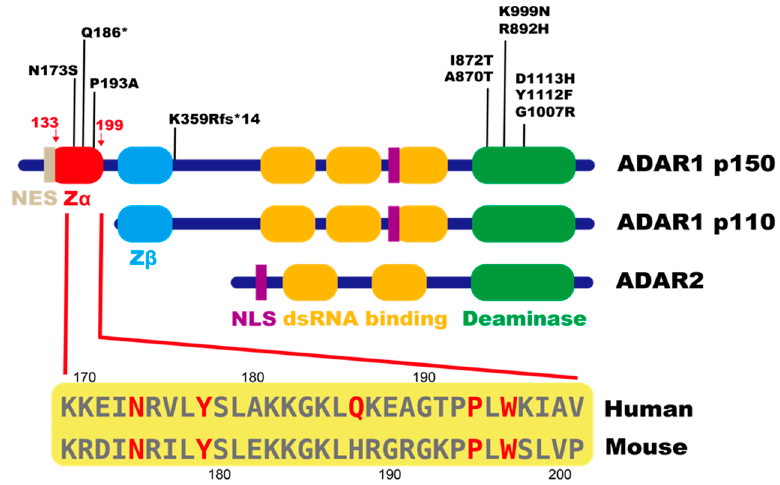
Figure 2. Structural representation of active human ADARs. Both ADAR1 and ADAR2 comprise double-stranded (ds)RNA-binding domains (orange), a C-terminal deaminase domain (green), and a nuclear localization signal (NLS; shown in purple). Both ADAR1 p150 and p110 comprise Z- DNA/RNA-binding domain β (Z β ; shown in light blue), which loses binding capacity to Z- DNA/RNA. In contrast, ADAR1 p150-specific Z α (red) can bind to Z-DNA/RNA. A nuclear export signal (NES; shown in light brown) is present only in the p150 isoform, which is predominantly localized in the cytoplasm. Amino acid substitution resulting from point mutations in the ADAR1 gene, identified in patients with Aicardi–Goutières syndrome (AGS), is also shown. Amino acid sequences of a part of Z α in human and mouse ADAR 150 are shown below. Critical residues for Z- DNA/RNA binding and resides mutated in patients with AGS are shown in red. ADAR1 is expressed as two isoforms: longer p150 and short p110, which are tran- scribed from the same genomic loci using different promoters and share Z-DNA/RNA- binding domain β (Z β ), dsRBDs, and the deaminase domain [21] (Figure 2). In contrast to N-terminal-truncated ADAR1 p110, which is driven by a constitutive promoter, ADAR1